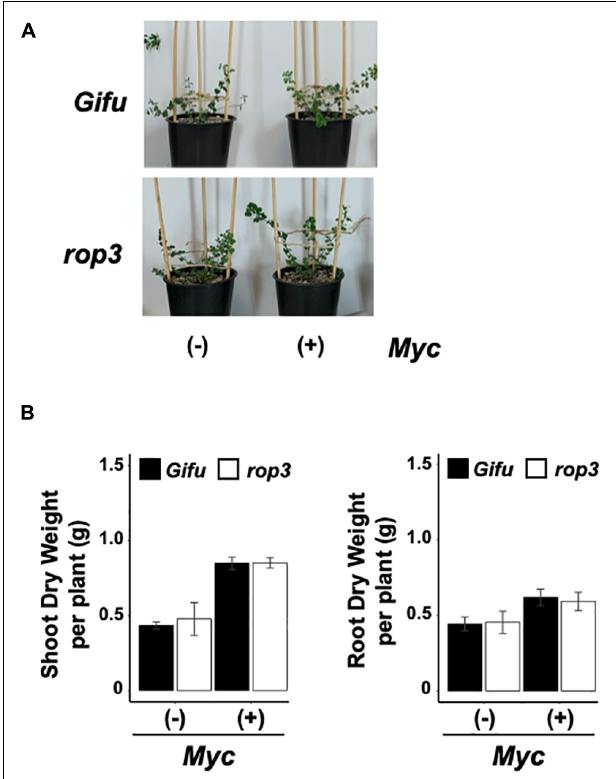
FIGURE 4 | ROP3 does not play a role in AM symbiosis in L. japonicus . (A) Development of Gifu wild-type and rop3 plants inoculated with R. irregularis . Pictures of representative plants are shown. (B) Shoot and root dry weight were determined for Gifu wild-type and rop3 plants with and without inoculation. Bars represent mean values ( ± SD) of 3 independent experiments ( n = >